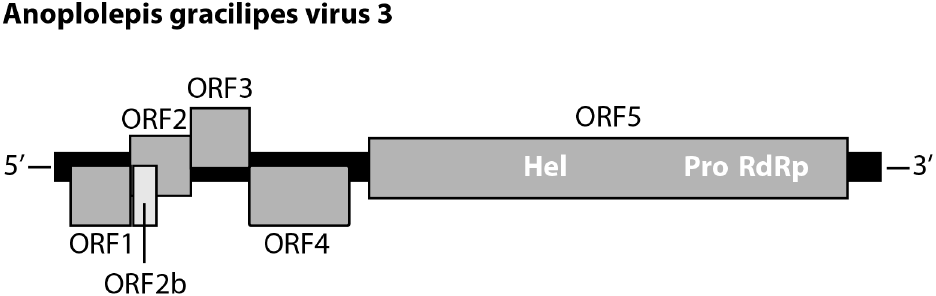
Figure 1. Genome structure of Anoplolepis gracilipes virus 3 (GenBank: MW078933). ORFs are represented by grey rectangles with vertical offsets indicating reading frames ( − 1, 0, +1) relative to the Hel-Pro-RdRp ORF (ORF5). Hel: RNA helicase, Pro: protease, RdRp: RNA-dependent RNA